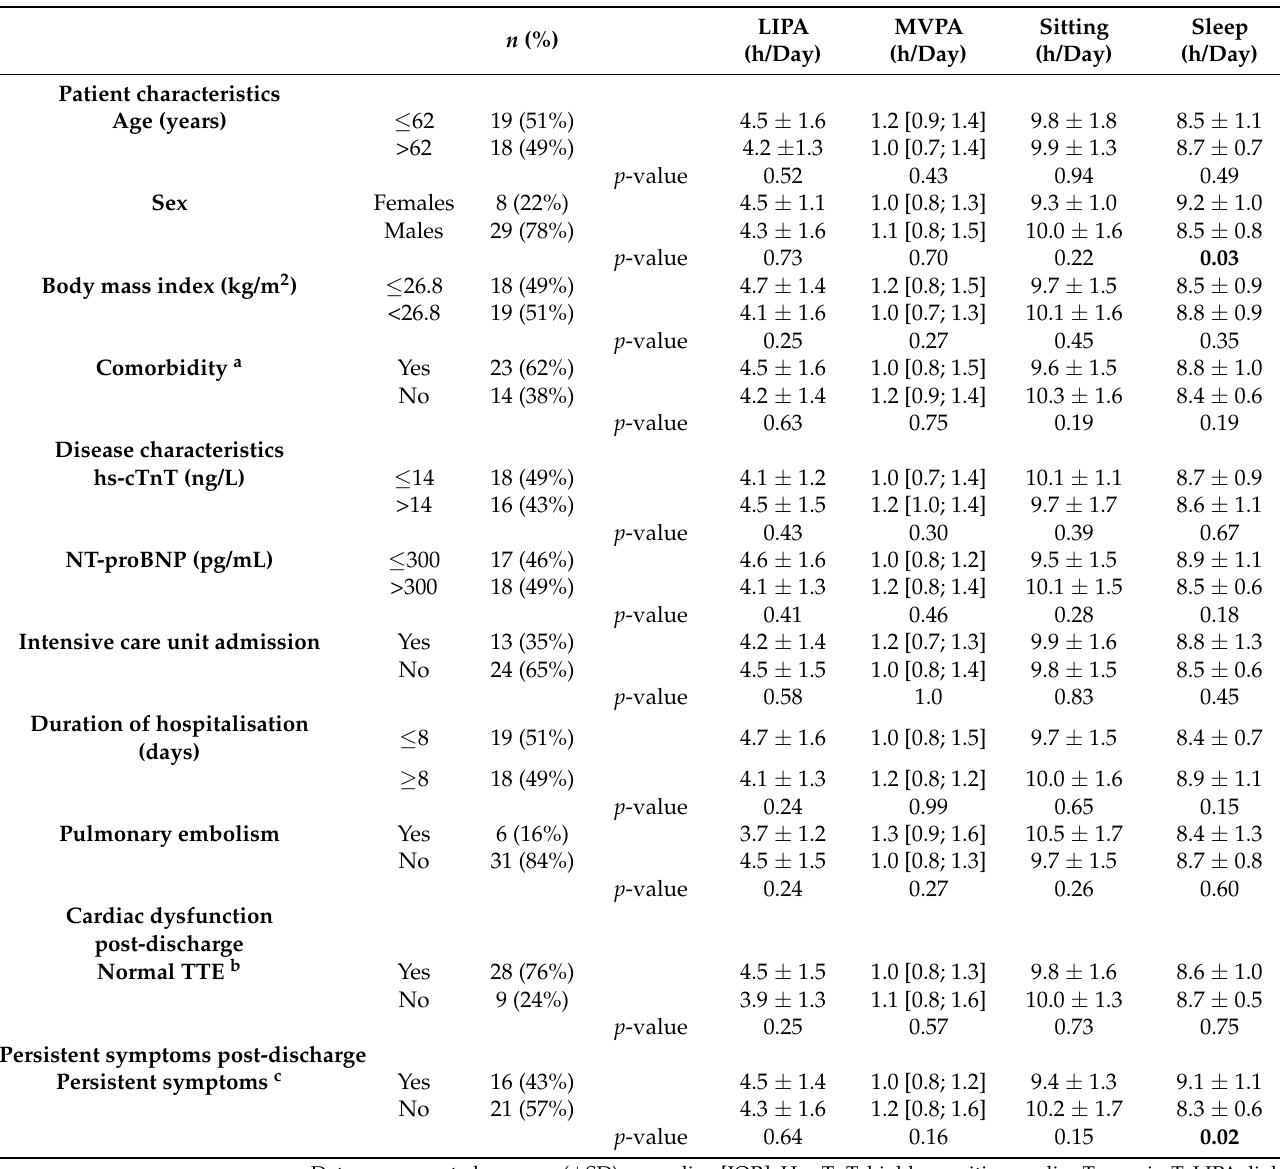
Table 2. Physical activity and sedentary time among subgroups of patients with